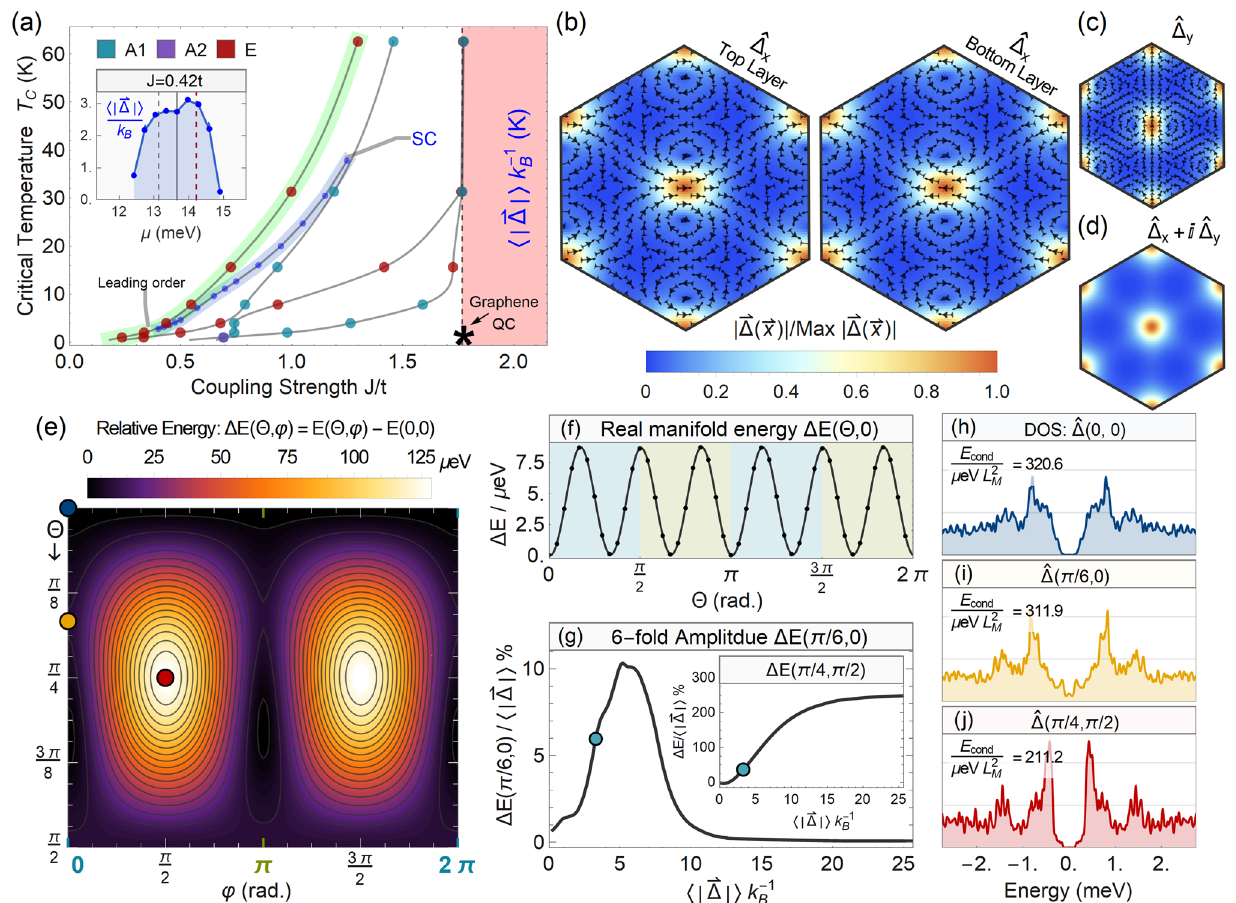
Fig. 2 Properties of the nematic superconducting state in twisted bilayer graphene (TBG). a Critical temperatures T c (left y -axis) obtained from the linear gap equation as a function of the coupling strength J / t with the Fermi level at the upper van Hove singularity (VHS). Plot marker color labels the symmetry of each solution, gray lines guide the eye. The leading two-fold degenerate solution is highlighted in green. Highlighted in blue are the spatial averaged amplitude order parameter, hj Δ ð x i Þji k (cid:1) 1 , (right y -axis) obtained from the non-linear self-consistency (SC) equation at zero temperature ( T = 10 − 7 t ). Inset: self-consistent B order parameter as a function of chemical potential μ at weak coupling J = 0.42 t . Vertical lines mark upper VHS (dashed red), lower VHS (dashed black), and half- fi lling (solid black). b Plot of the order parameter fi eld ^ Δ x throughout the moiré cell in the top (left) and bottom graphene layer (right). Underlying color intensity plot shows the amplitude, clearly depicting a global, moiré-scale, nematicity. The streamlines of the local vectors fi eld χ ( x ) illustrate the intricate atomic- scale nematicity in the local d -wave bond order parameters, as well as the superconducting π -phase-shift between the two layers. c Same as b but for ^ Δ y in the top graphene layer. d Color intensity plot of the order parameter fi eld amplitude for the chiral ^ Δ x þ i ^ Δ y solution in the top graphene layer. e Relative free energy landscape at T = 0 for all independent linear combinations ^ Δ ð Θ ; φ Þ of the ^ Δ x ; y solutions. f Cut along the real-valued linear combinations of e , which due to gauge invariance are located at the lines φ = 0,2 π (blue) and φ = π (green) in e . The line is a least square fi t, showing a three-fold degenerate nematic ground state. g Energy difference between the most and least favorable nematic combinations in f as a function of tuning the averaged order parameter amplitude, with dot marking value for J = 0.43 t . Inset: energy difference between most favorable nematic state and the time reversal symmetry (TRS) breaking chiral ^ Δ x þ i ^ Δ y combination. h – j Low-energy density of states (DOS) for most favorable nematic, least favorable nematic, and chiral combination, respectively, extracted at the points of the same color in e . Plots show that the ground state is fully gapped, while the other combinations show a (partially) fi lled energy gap re fl ecting lower superconducting condensation energies (given in fi gures). For all but panels a and g : J = 0.43 t and chemical potential aligning the Fermi level with the upper VHS (band fi lling ν ≈ 1), but conclusions are unchanged for other J Further analyzing the zero temperature self-consistent solu- tions at different experimentally relevant couplings and band fi llings, we always fi nd that they are exclusively real-valued, even when self-consistency is achieved iteratively from an initial complex number fi eld con fi guration. In fact, we fi nd that the self- consistent solutions are always real-valued linear combinations of ^ Δ ^ Δ the two leading and degenerate solutions and of the x y linear gap equation, see Methods. This makes TBG a nematic superconductor 54 , with nematic symmetry breaking on the moiré length scale. As both the normal-state and electronic interactions are fully isotropic, this nematicity is entirely due to spontaneous symmetry breaking in the superconducting state.